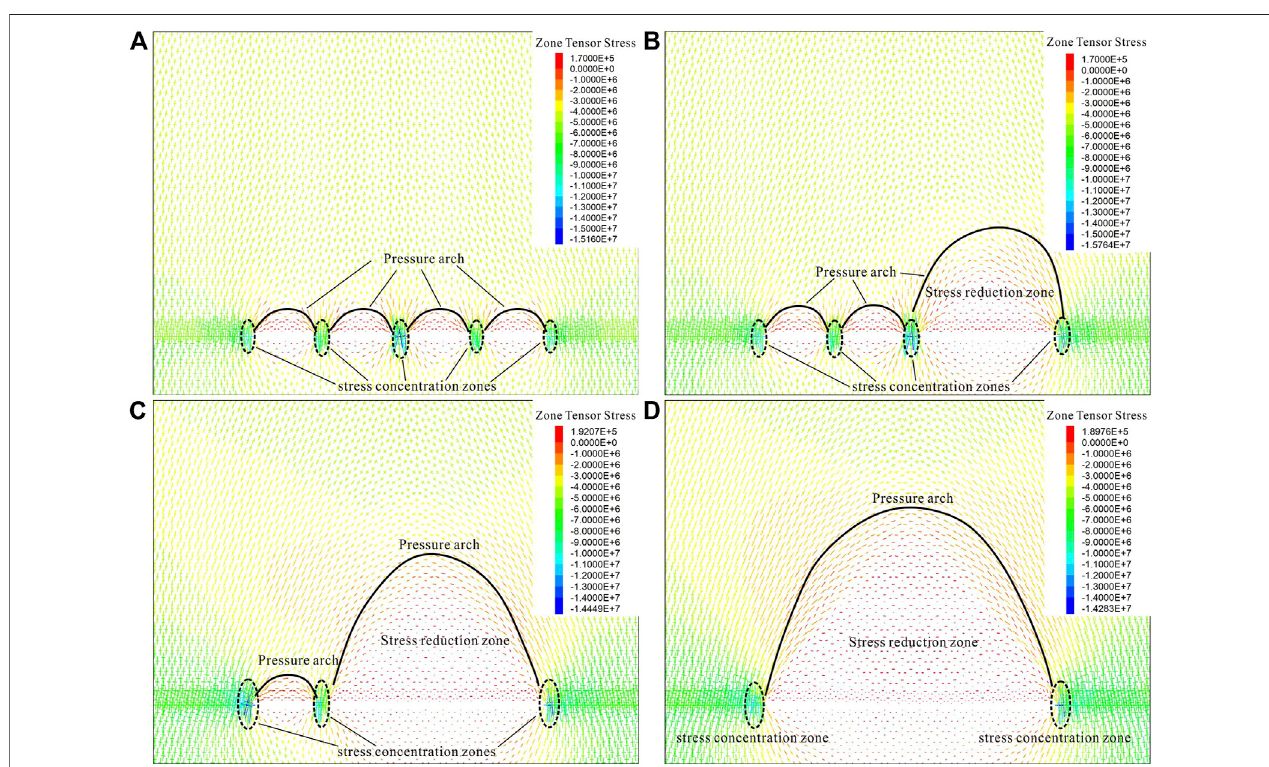
FIGURE7| Thedynamicchangeofthetensorstresszoneoftheoverlyingstratainthemodel,miningdistanceofcoalface: (A) 64 m, (B) 70 m, (C) 76 m, (D) 82 m.